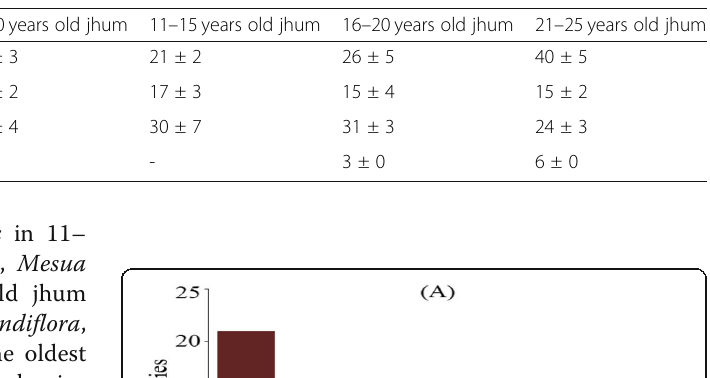
Table 1 Species richness of different communities in different aged jhum fallows and old-growth forest. Data are presented as mean ± standard errors ( n = 3)